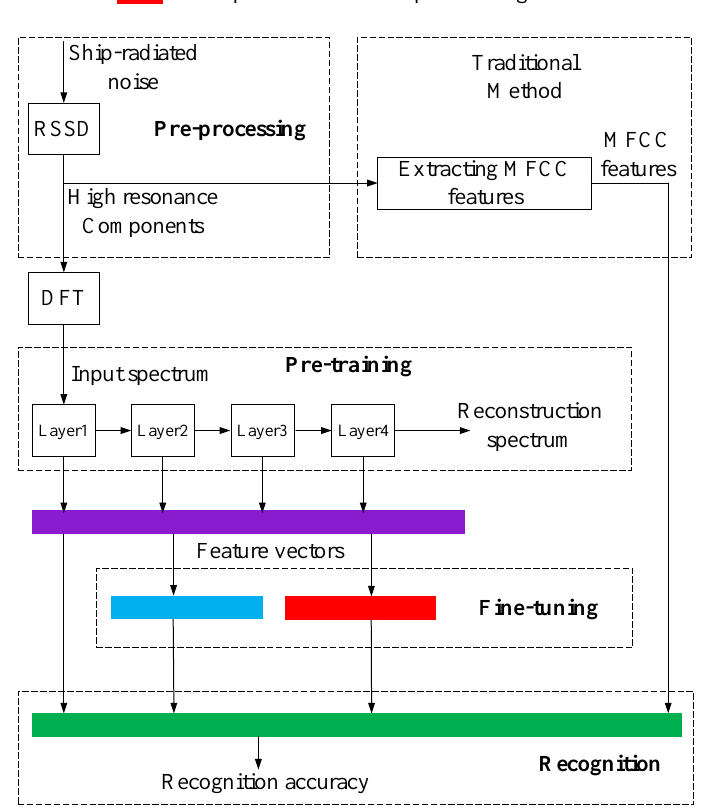
Figure 16. Procedure of the underwater acoustic target recognition